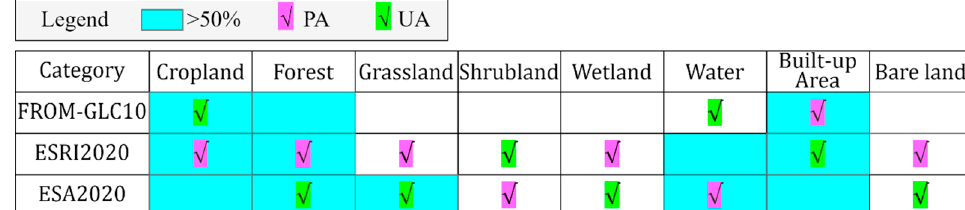
Figure 12. Suggestions for each class. Blue indicates that it meets our validation criteria, that is, the UA and the PA of a single class both reach 50%. The check marks indicate the highest PA (pink) and UA (green) values for each class among the three land cover products.